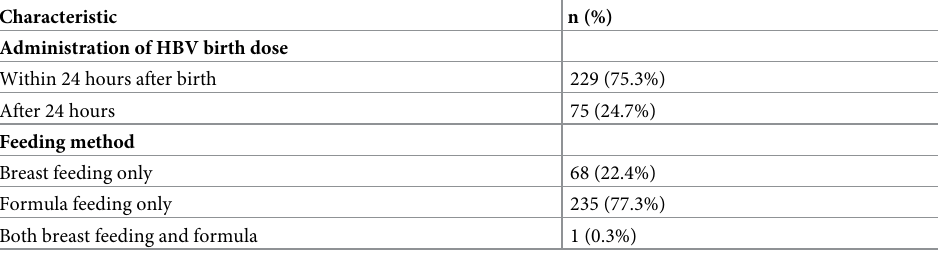
Table 1. Demographics for children exposed to HIV (n = 304).